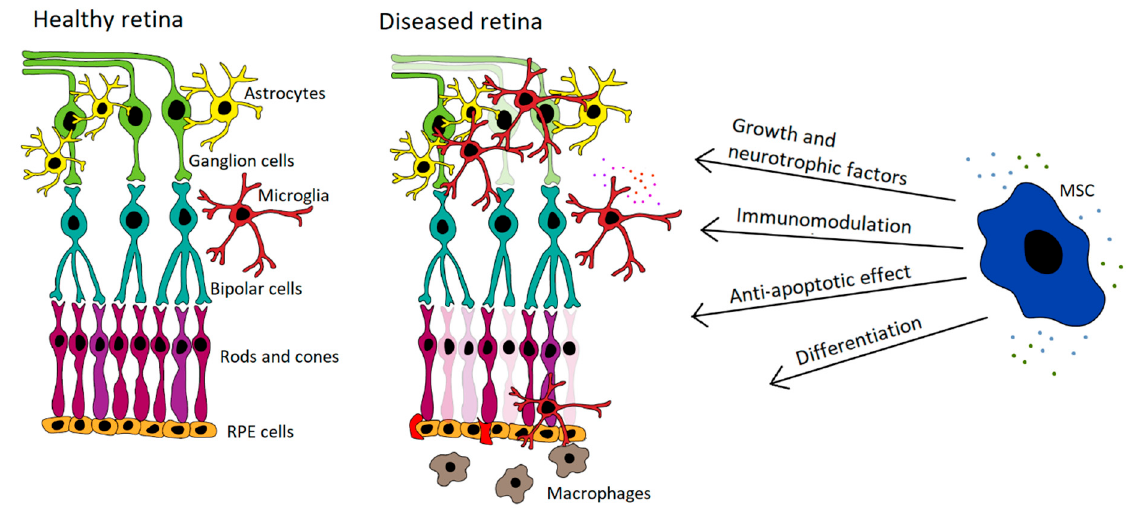
Figure 1. The main mechanisms of the therapeutic effect of mesenchymal stem cells (MSCs) for retinal diseases. MSCs contribute to treatment of retinal disorders by multiple mechanisms involving the production of growth and neurotrophic factors, immunomodulatory actions, by antiapoptotic effect and by direct cell differentiation.